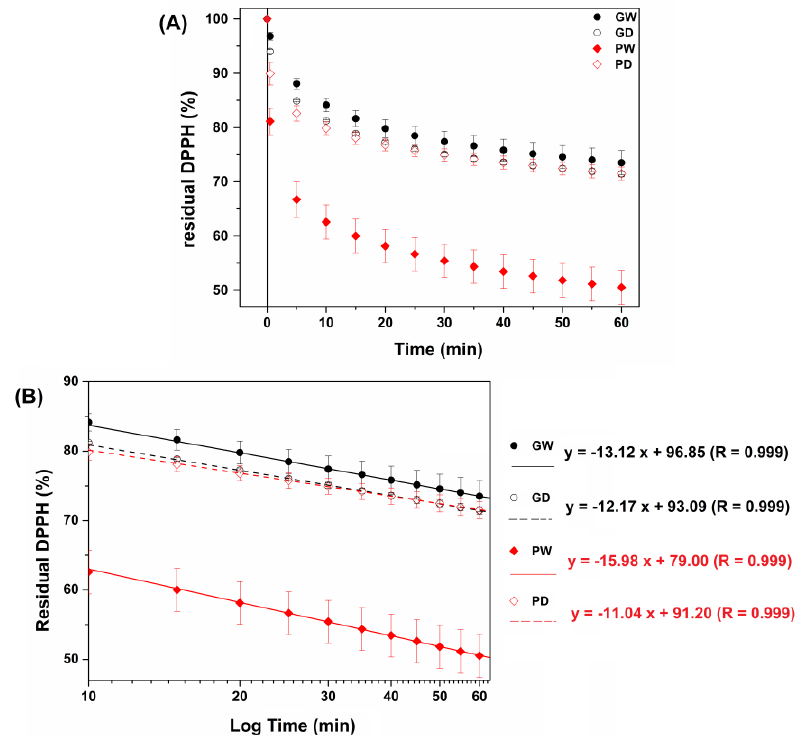
Figure 1. ( A ) Residual DPPH (%) as a function of incubation time when evaluating the GW (black— solid symbol), GD (black—open symbol), PW (red—solid symbol) and PD (red—open symbol) extracts. ( B ) Data in the semi-logarithmic scale and linear curve fitting (linearity range: 20–60 min) ( n = 9).